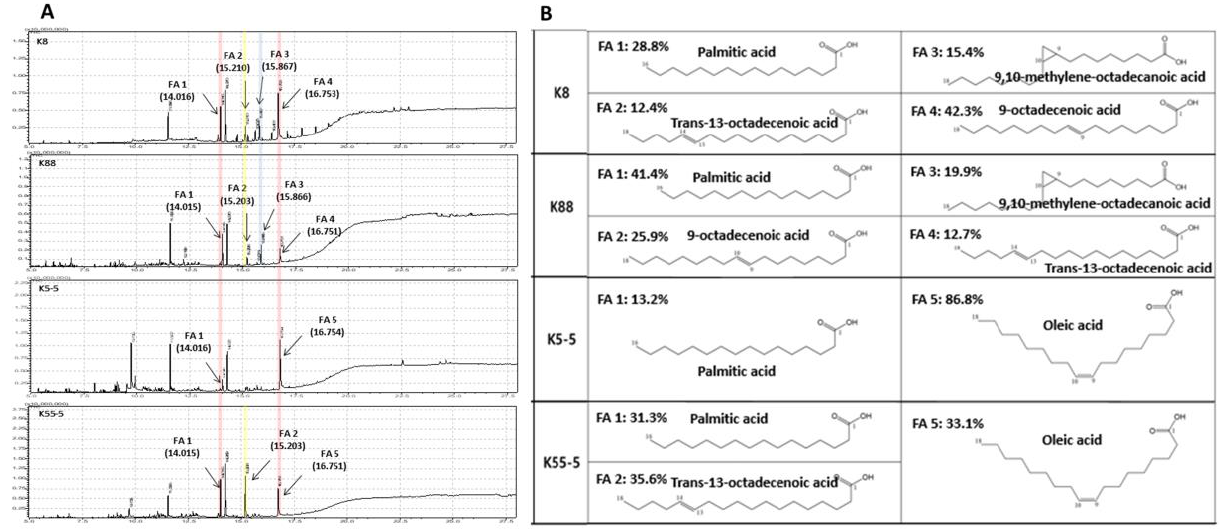
Figure 3. Structural analysis of four LTAs. ( A ) GC-MS analysis of four LTAs. ( B ) Composition and content of LTA glycolipids predicted by GC-MS